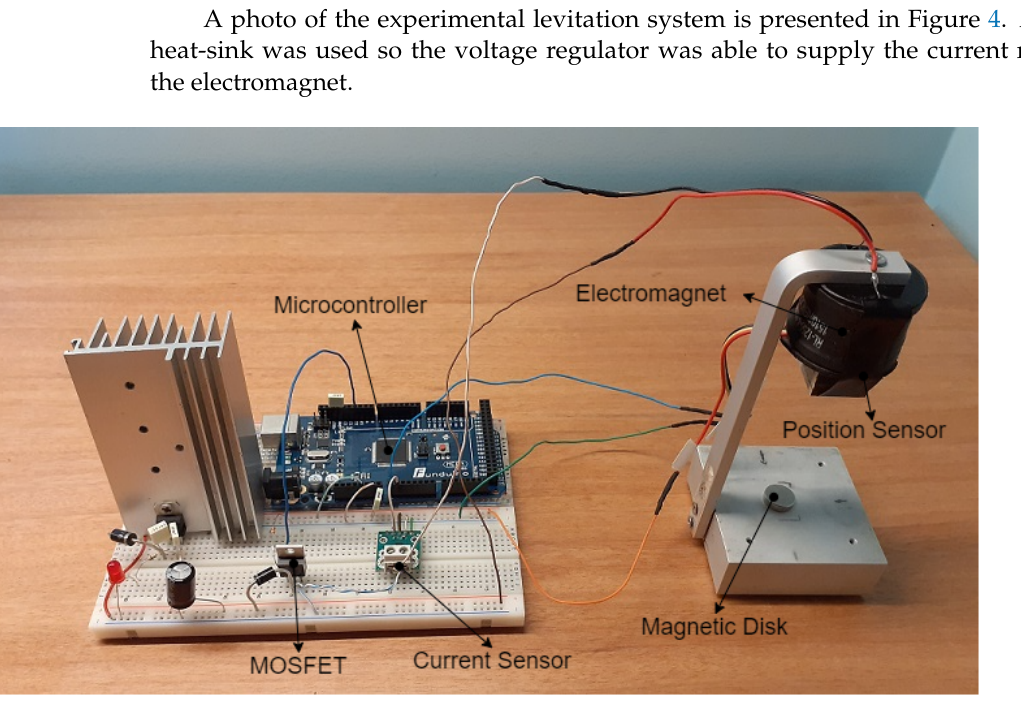
Figure 4. Experimental electromagnetic